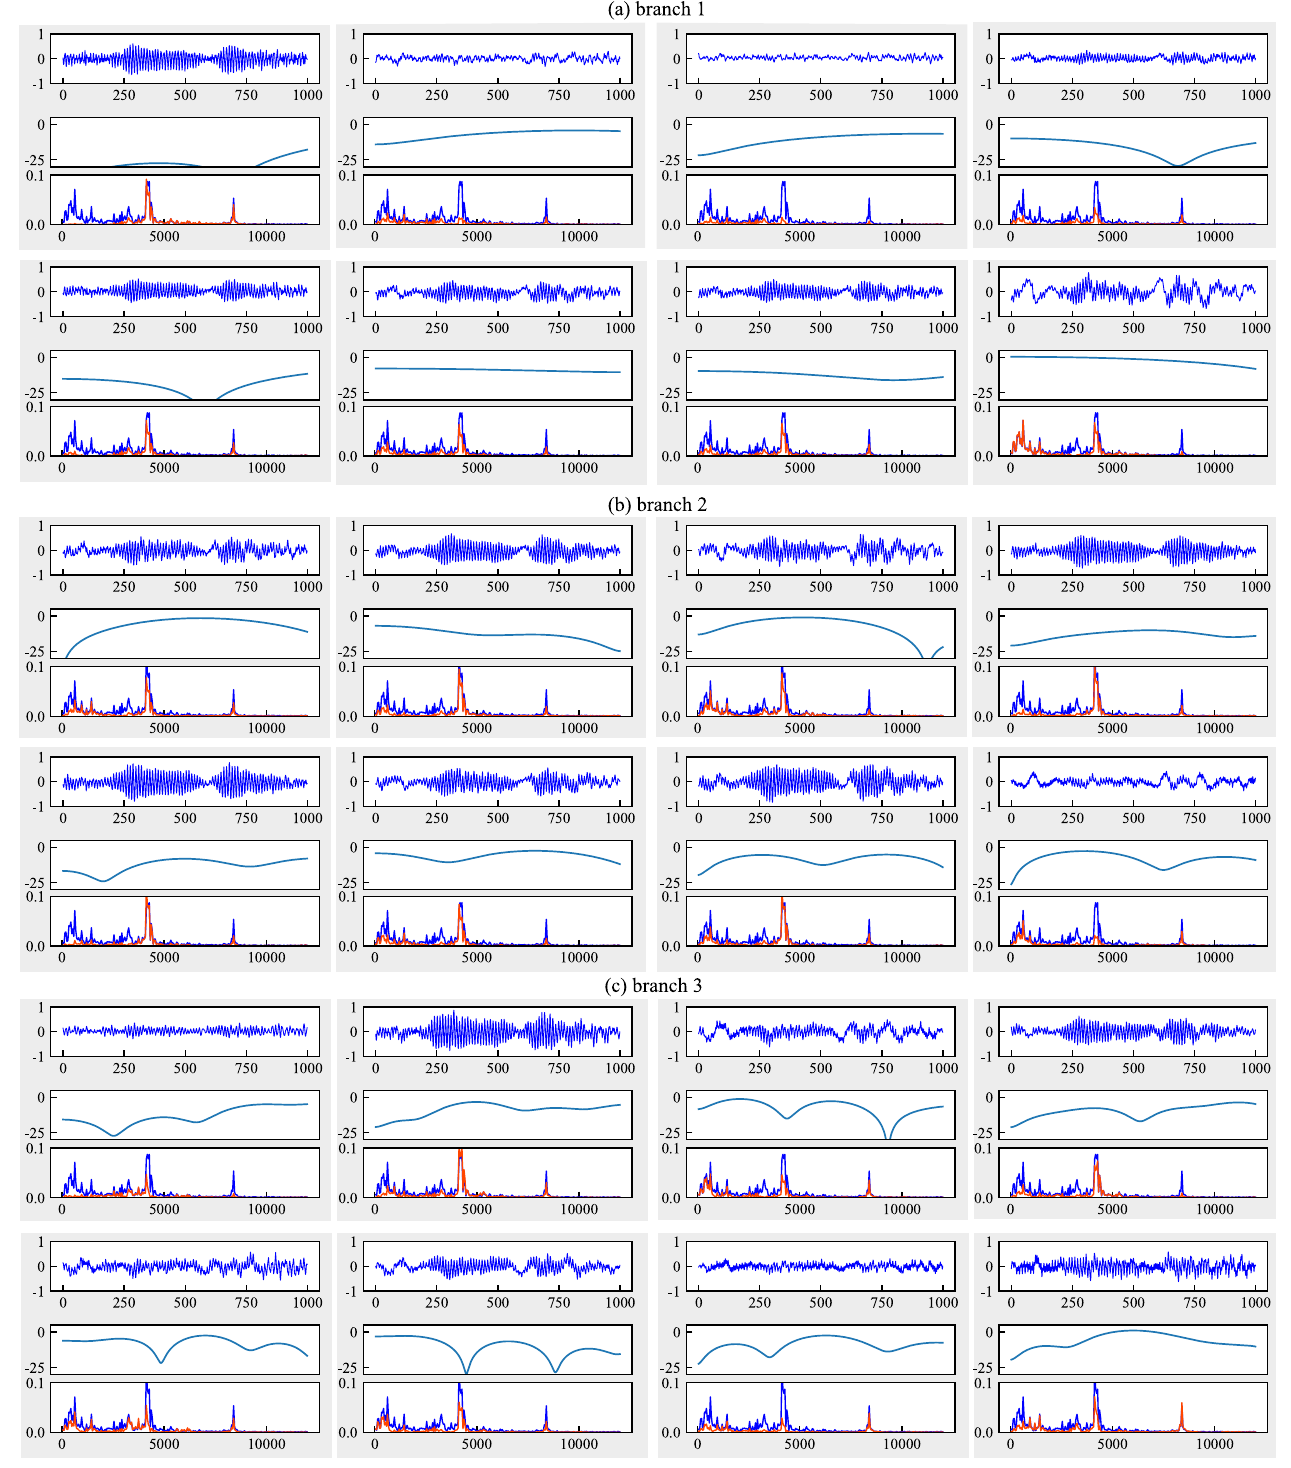
Figure 15. Amplitude-frequency characteristic curves of each filter in the first layer of FFCNN-B from task B 5 → B 1. ( a – c ) represent the branches 1, 2, 3 with a dilation rate = 1, 3, 5,